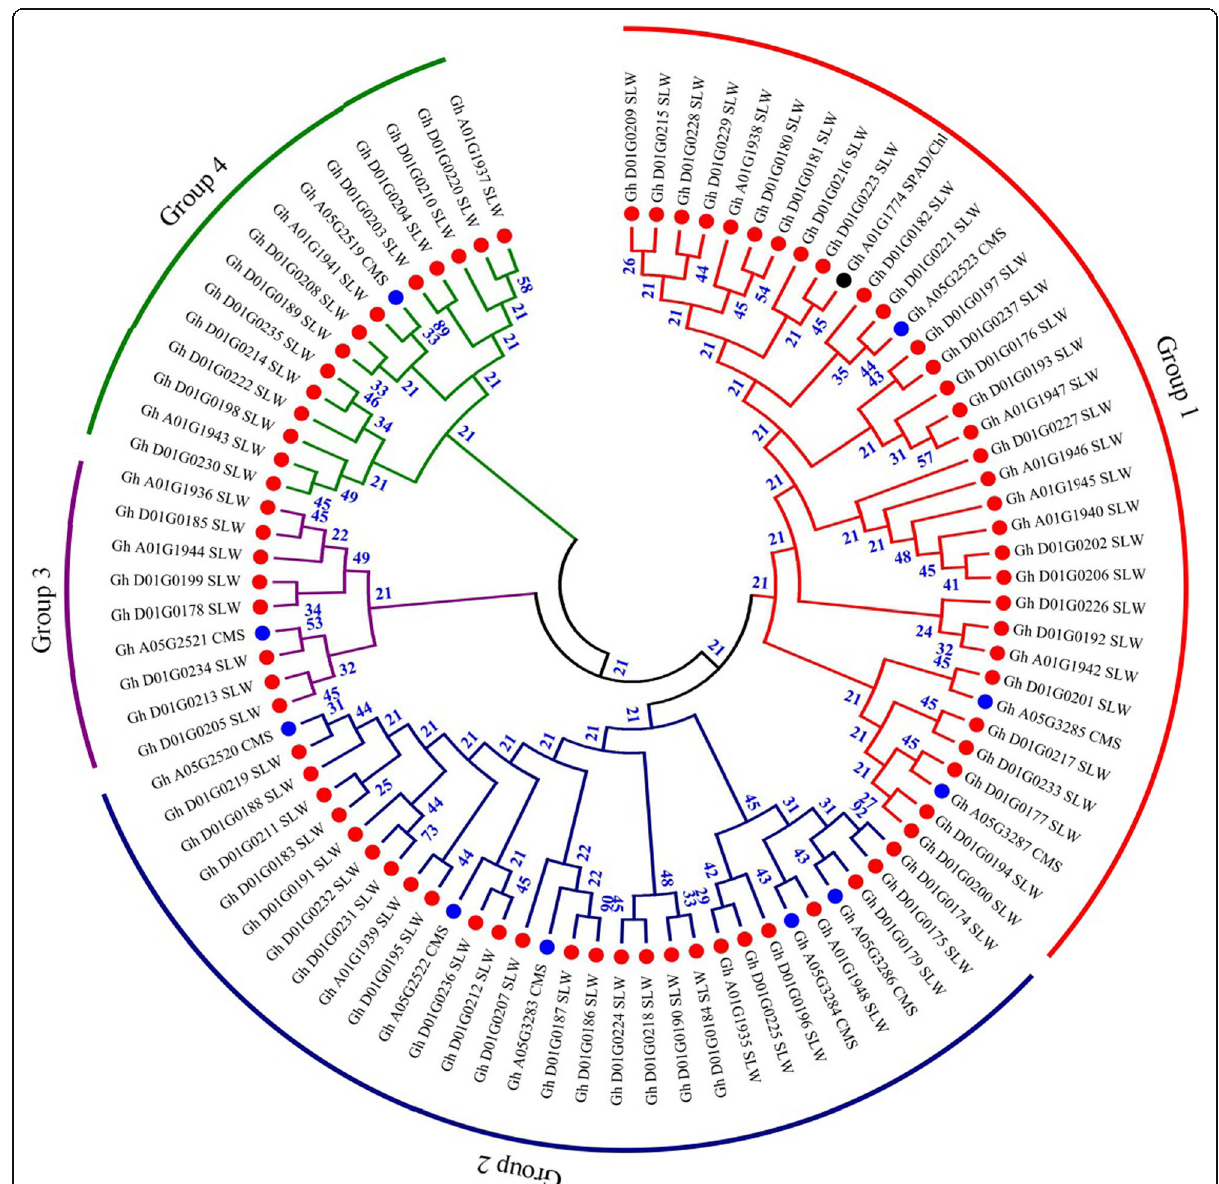
Fig. 4 Phylogenetic tree analysis of the mined genes within the consistent QTL regions for the three major